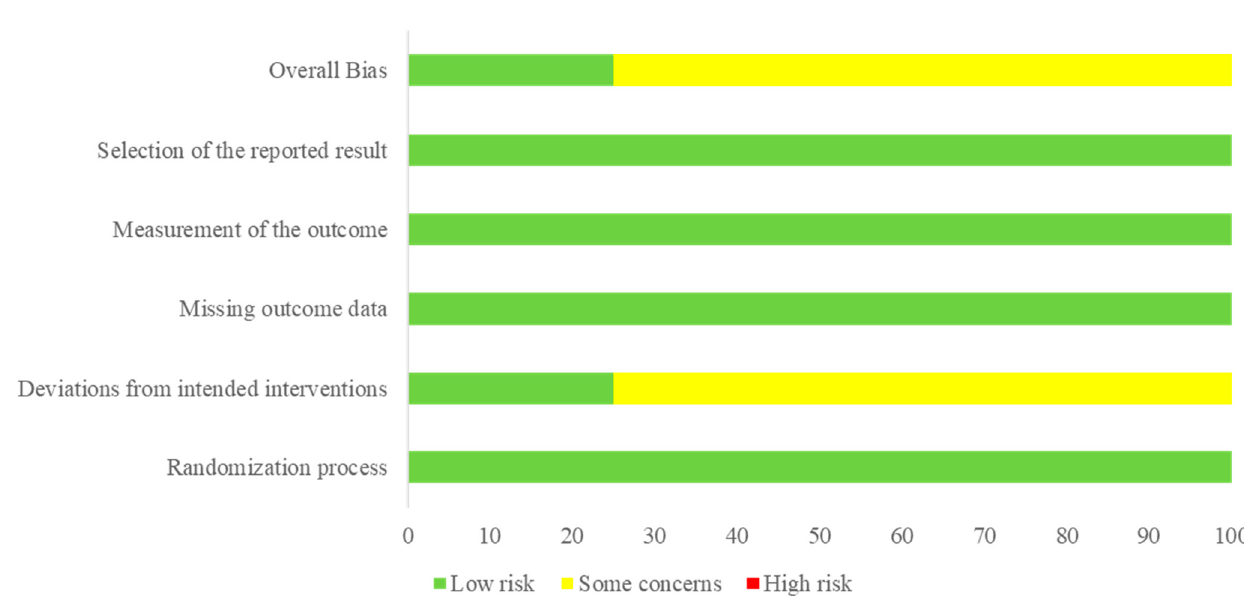
Figure 1. Flowchart of the meta-analysis.